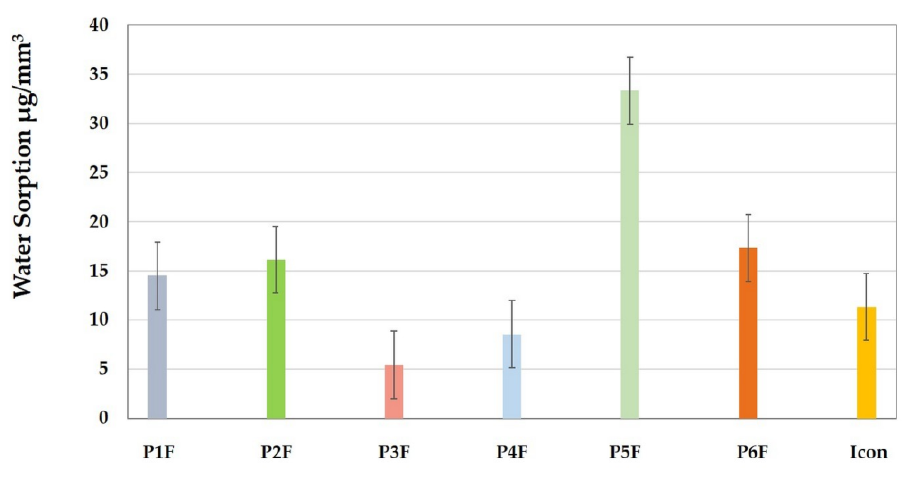
Figure 2. Sorption value of the investigated infiltrants (mean ± standard deviation).